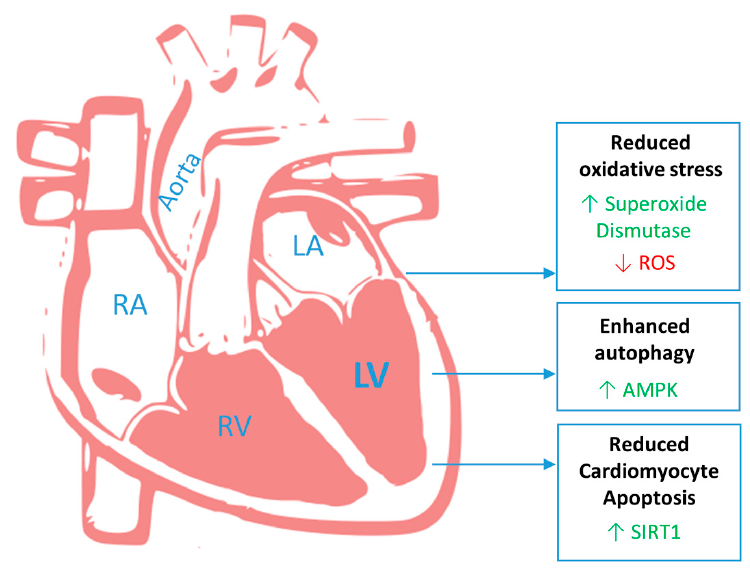
Figure 2. Resveratrol improves pathological cardiac features in Marfan syndrome by increasing beneficial (green) superoxide dismutase, AMPK and SIRT1 and decreasing detrimental (red) ROS. ROS: reactive oxygen species; AMPK: AMP-activated protein kinase; SIRT1: sirtuin-1; RA: right atrium; RV right ventricle; LA: left atrium; LV: left ventricle.